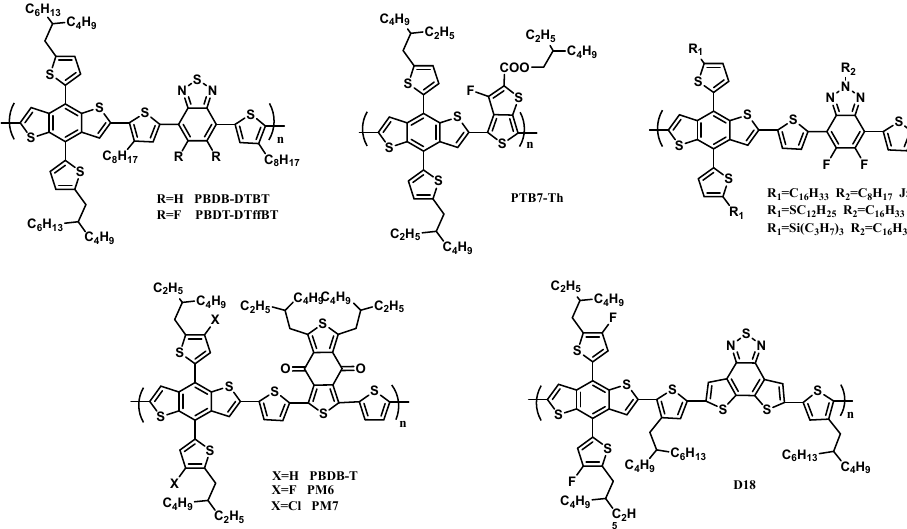
Figure 2. High-efficient printable donor materials listed in Table 1.